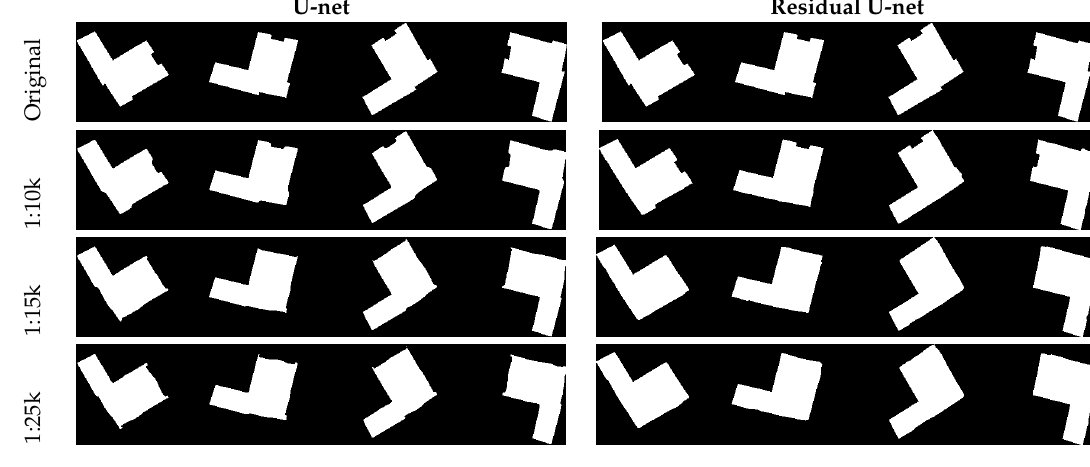
Figure 12. Evaluation of different models on buildings with orientations at three target map scales.